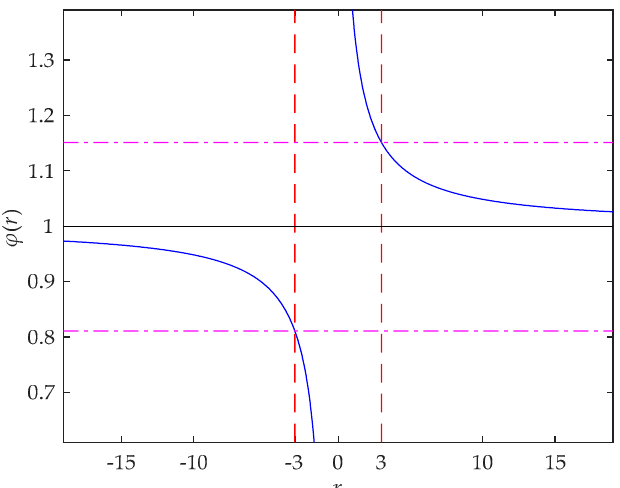
( ) ( ) r ϕ . The value of r ϕ converges to 1 with the increase of SNR. When r Figure 2. The curve of Figure 2. The curve of ϕ ( r ) . The value of ϕ ( r ) converges to 1 with the increase of SNR. When r is equal ( ) to 3, the value of ϕ ( r ) is equal to 1.1507. When r is equal to − 3, the value of ϕ ( r ) is equal to r ϕ is equal to 1.1507. When r is equal to 3 − , the value of is equal to 3, the value of equal to 0.8109.